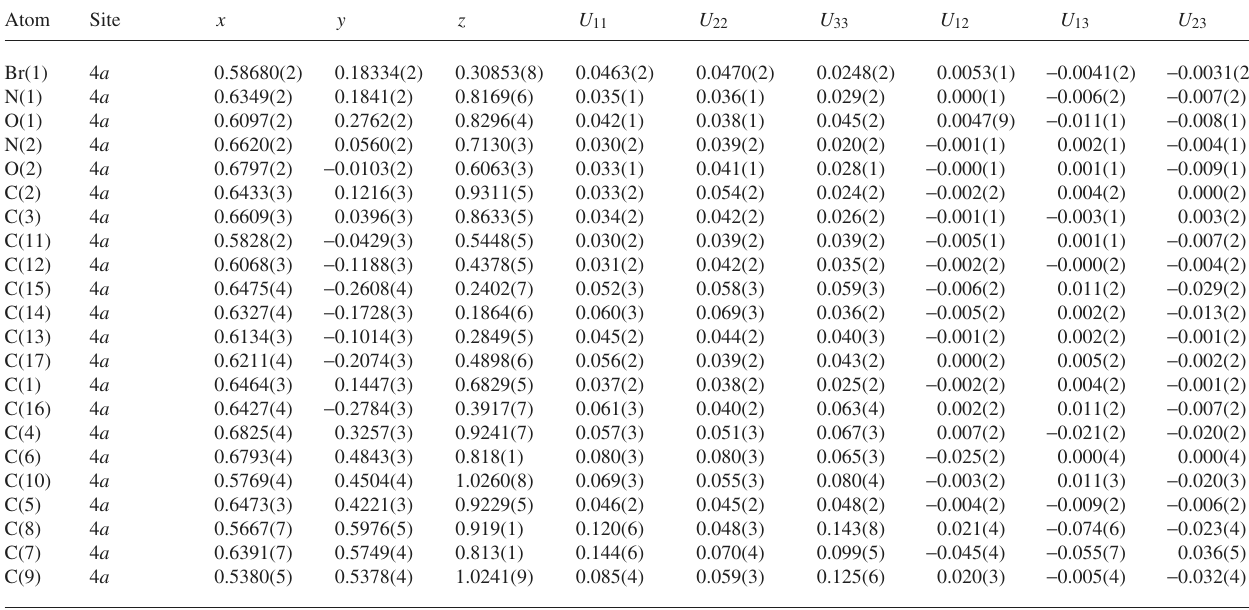
Table 3. Atomic coordinates and displacement parameters (in Å 2 )